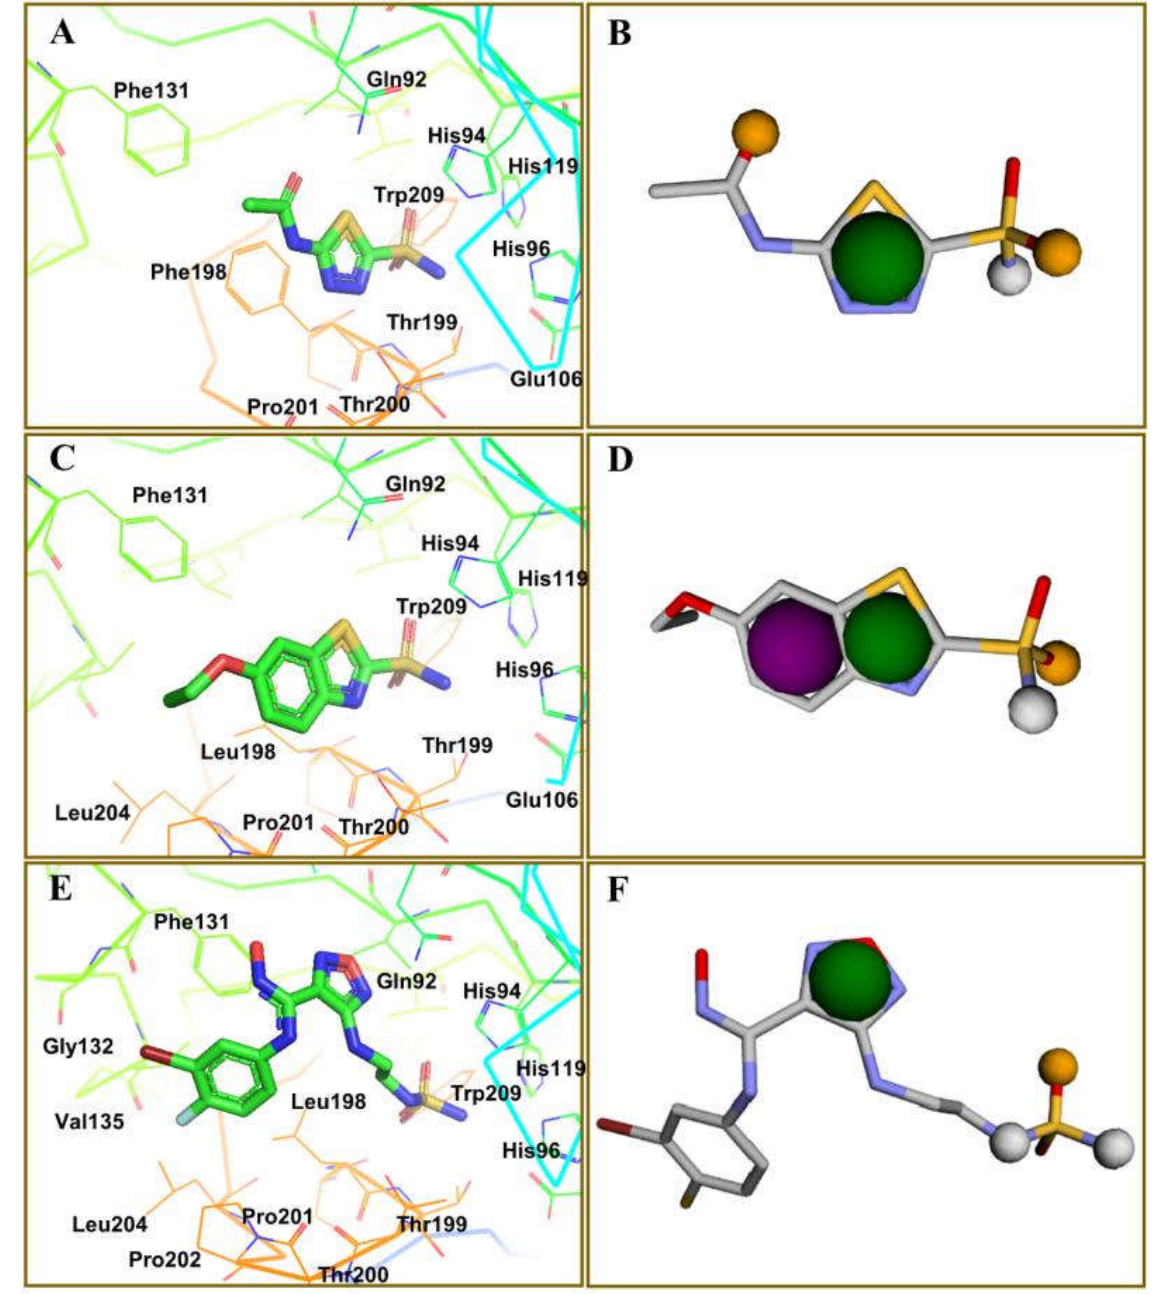
Figure 2. Key interacting residues involved in the intermolecular interactions of co-crystallized inhibitors of carbonic anhydrase with the 1,3,4-thiadiazole (PDB: 1YDB ( A )), 1,3-benzothiazole (PDB: 6BCC ( C )), and 1,2,5-oxadiazole (PDB: 6IC2 ( E )) scaffolds. Common pharmacophoric features are presented ( B , D , F ).